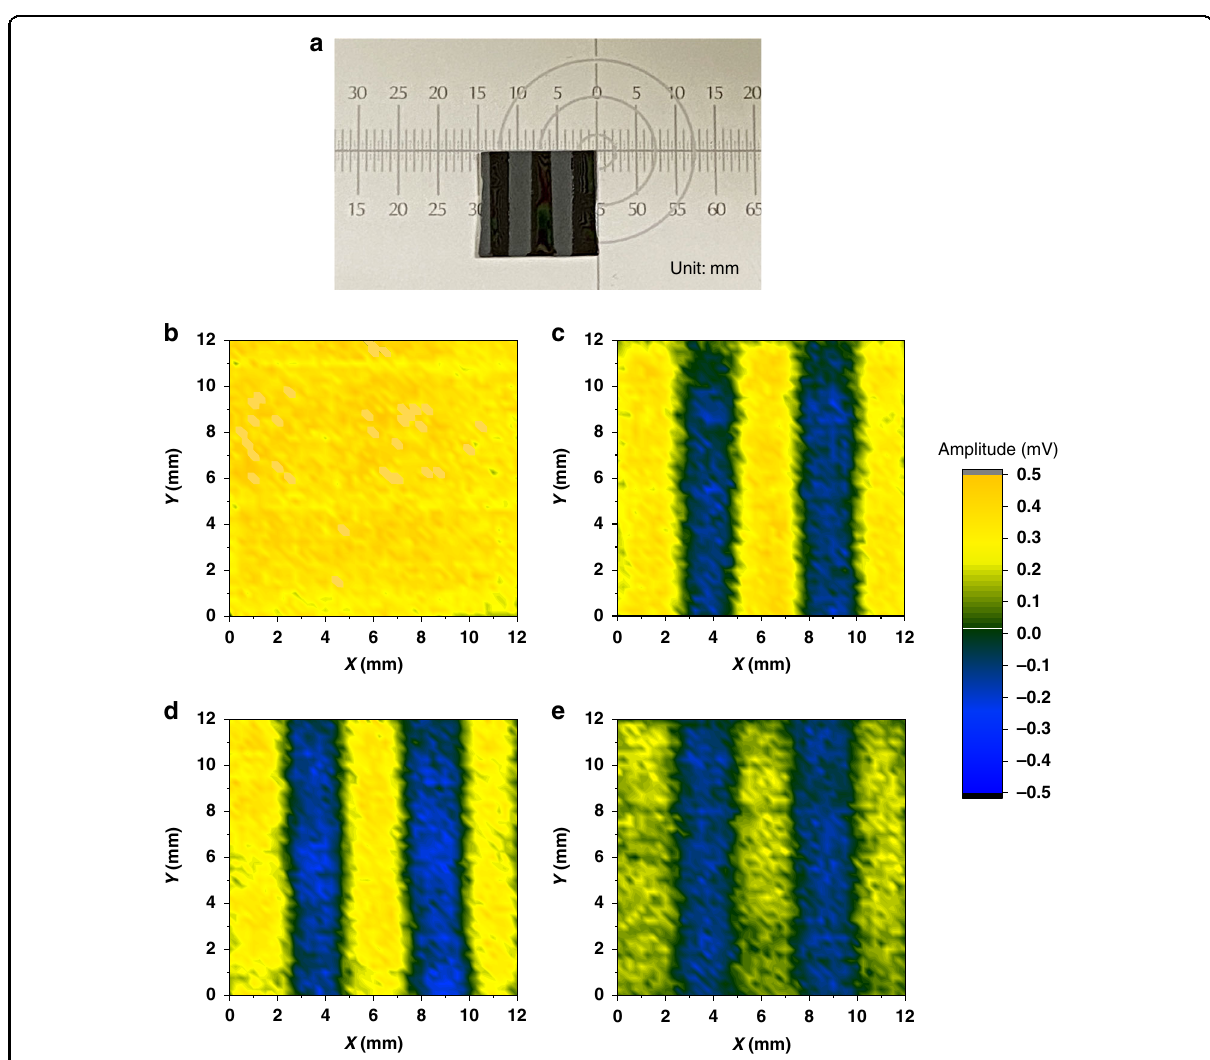
Fig. 7 LTEM images of the line-space structure in different conditions. a Image of the Si sample with a 2.5 mm interval line-space structure of PR on the surface, which can protect the Si surface from BHF etching. LTEM images of the Si sample ( b ) before etching, after 1% dilute BHF etching for ( c ) 180 s and ( d ) 300 s, and ( e ) after the removal of the